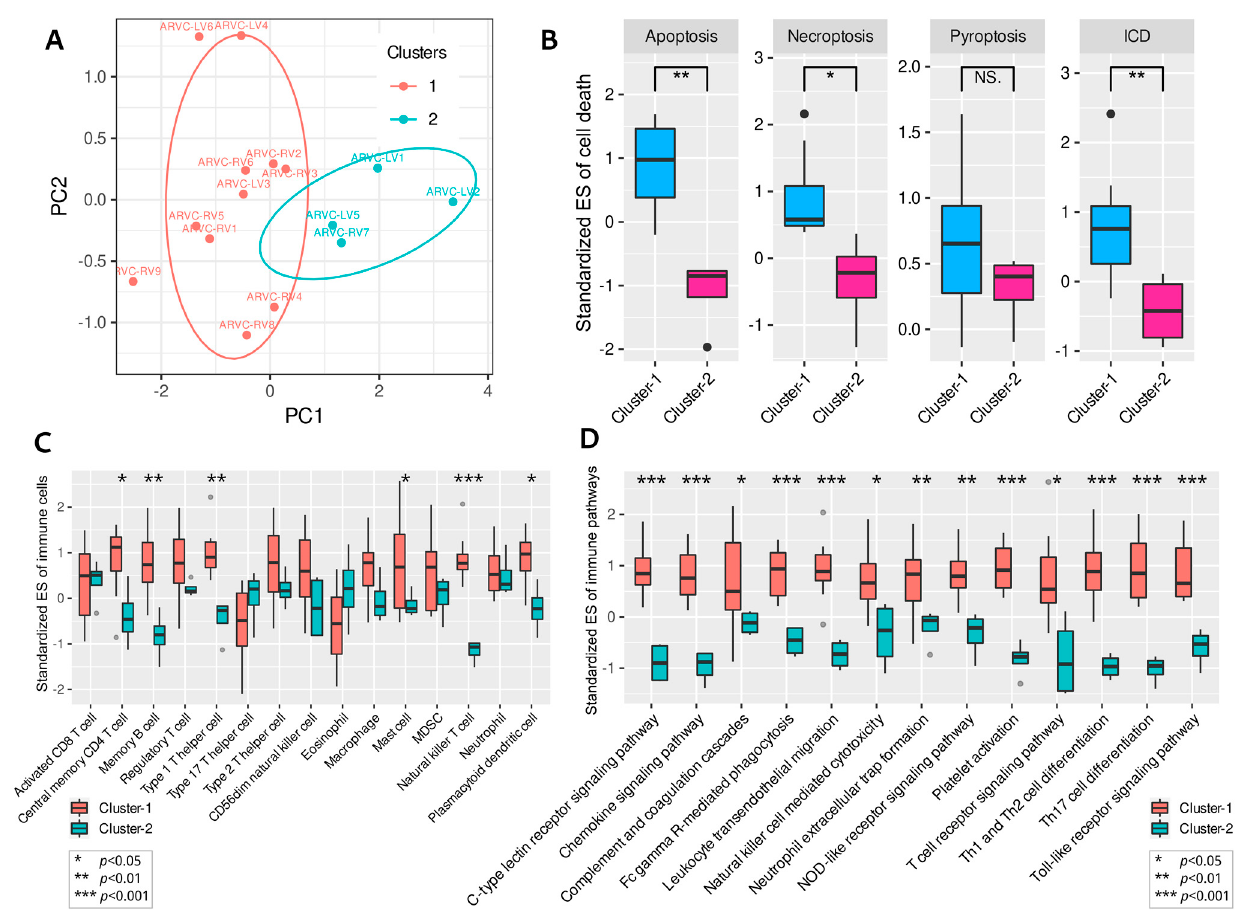
Figure 4. Clustering of ARVC samples based on the up-regulated cell death processes. ( A ): Principal component analysis and K-means clustering of the ARVC samples. ( B ): Comparisons of the four up-regulated cell death processes in ARVC between cluster-1 and cluster-2. ( C ): Comparisons of the highly infiltrated immune cells in ARVC between cluster-1 and cluster-2. ( D ): Comparisons of the up-regulated immune pathways in ARVC between cluster-1 and cluster-2. Abbreviations are the same as in Figures 1–3. *** p < 0.001; ** p < 0.01; * p < 0.05; NS, non-significance.